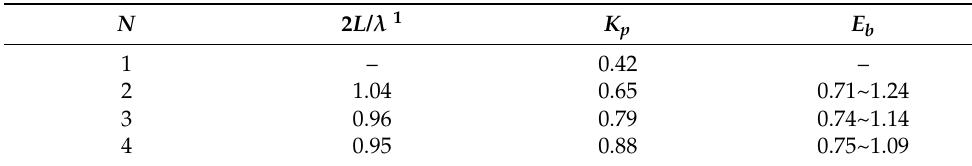
Table 1. Characteristics of Bragg reflection under different numbers of plates ( d / h = 0.5 and L / h =